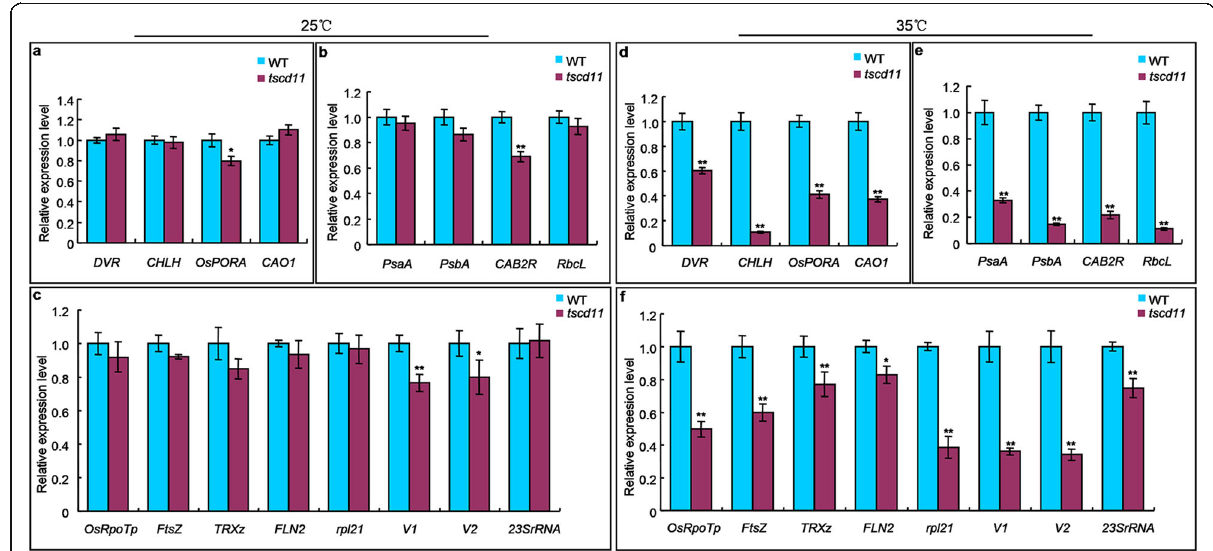
Fig. 7 Transcriptional expression of genes related to Chl biosynthesis, photosynthesis and chloroplast development. a - c Expression of genes associated with Chl biosynthesis ( a ), photosynthesis ( b ) and chloroplast development ( c ) in WT and tscd11 mutant at 25 °C. d-f Expression of genes associated with Chl biosynthesis ( d ), photosynthesis ( e ) and chloroplast development ( f ) in WT and tscd11 mutant at 35 °C. The rice Histone gene was used as an internal control. The expression level of each tested gene in WT was set to 1.0. Data represent mean ± SD (n = 3). * p < 0.05, ** p < 0.01 (Student ’ s t